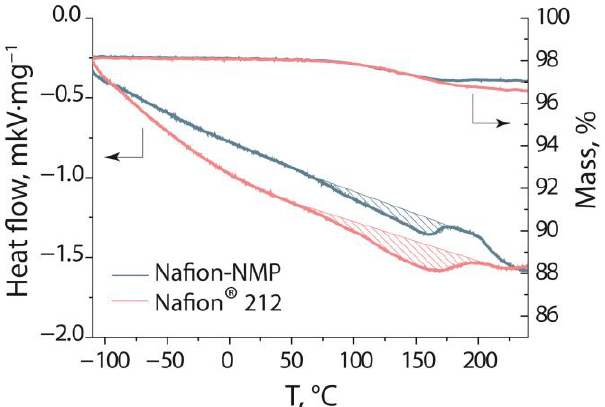
Figure 2. DSC curves and mass loss as a function of temperature for Nafion ® 212 and Nafion-NMP dry membranes (indicated in the figure).